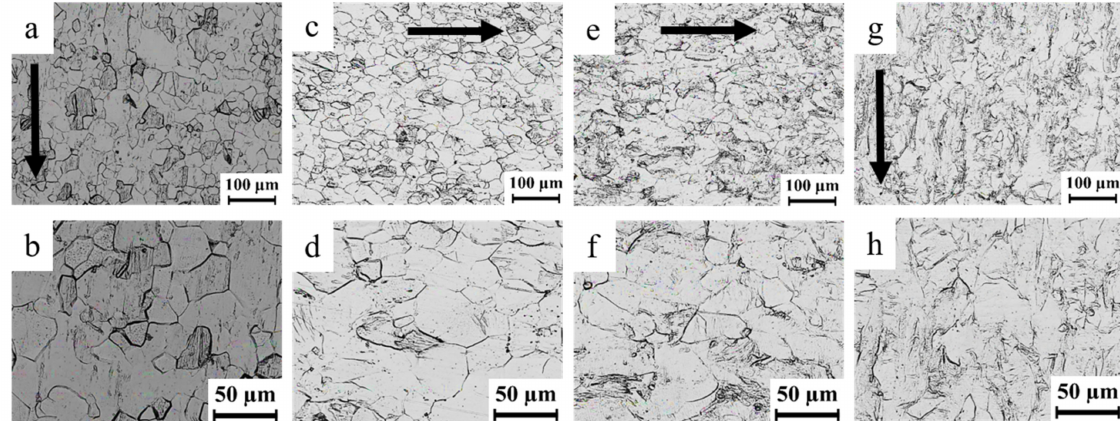
Figure 3. Metallographic structure of TA2 alloy with different deformation: ( a , b ) 20%, ( c , d ) 40%, ( e , f ) 60%, ( g , h ) 80%. The EBSD pole figures of the 0%, 40%, and 80% deformed samples are shown in